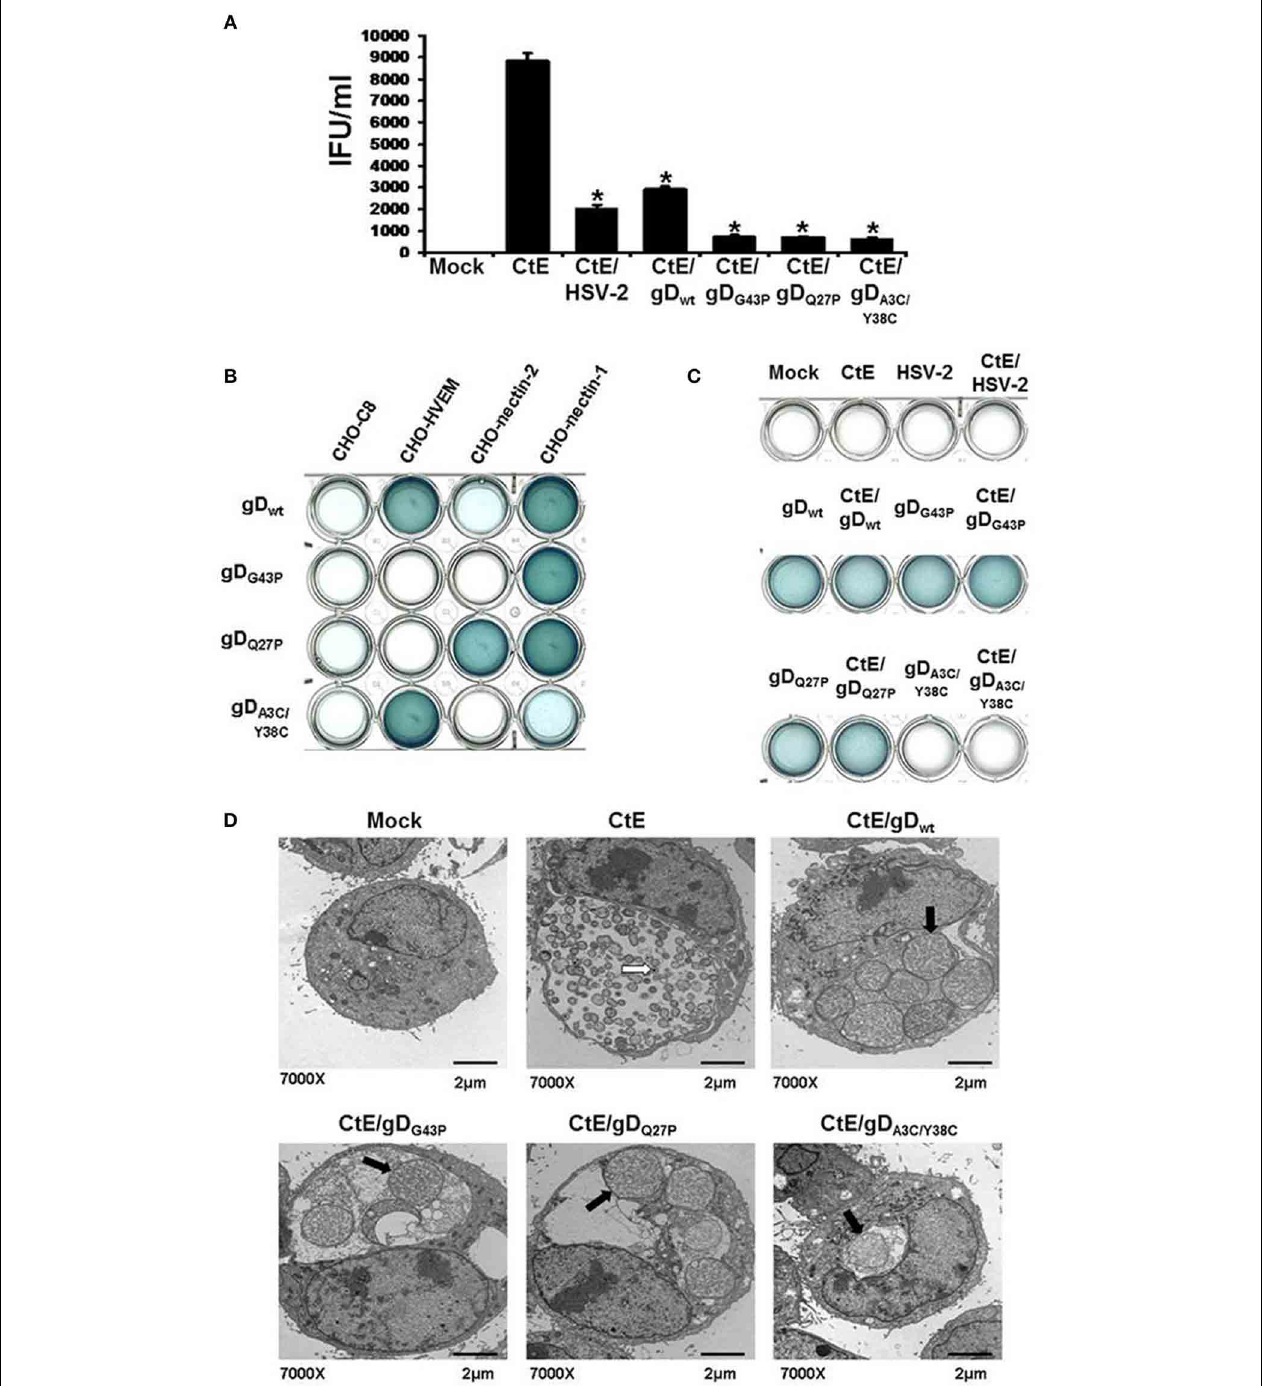
FIGURE 1 | HSV co-infection-induced chlamydial persistence signal requires viral attachment/entry via nectin-1. (A) HeLa cells were either mock-, singly-, or co-infected with CtE and various wild type (HSV-2 and HSV-1 gD wt ) or mutant viruses (gD G43P , gD Q27P , and gD A3C / Y38C ). Cells were collected 20h pvi and processed for chlamydial EB titration analyses. Results are expressed as the mean ± s.e.m. of three biological replicates. A single asterisk ( ∗ ) indicates significant difference ( p ≤ 0 . 05) compared to CtE. (B) CHO-C8, CHO-HVEM, CHO-nectin-1 and CHO-nectin-2, were infected with HSV-1 gD wt ,